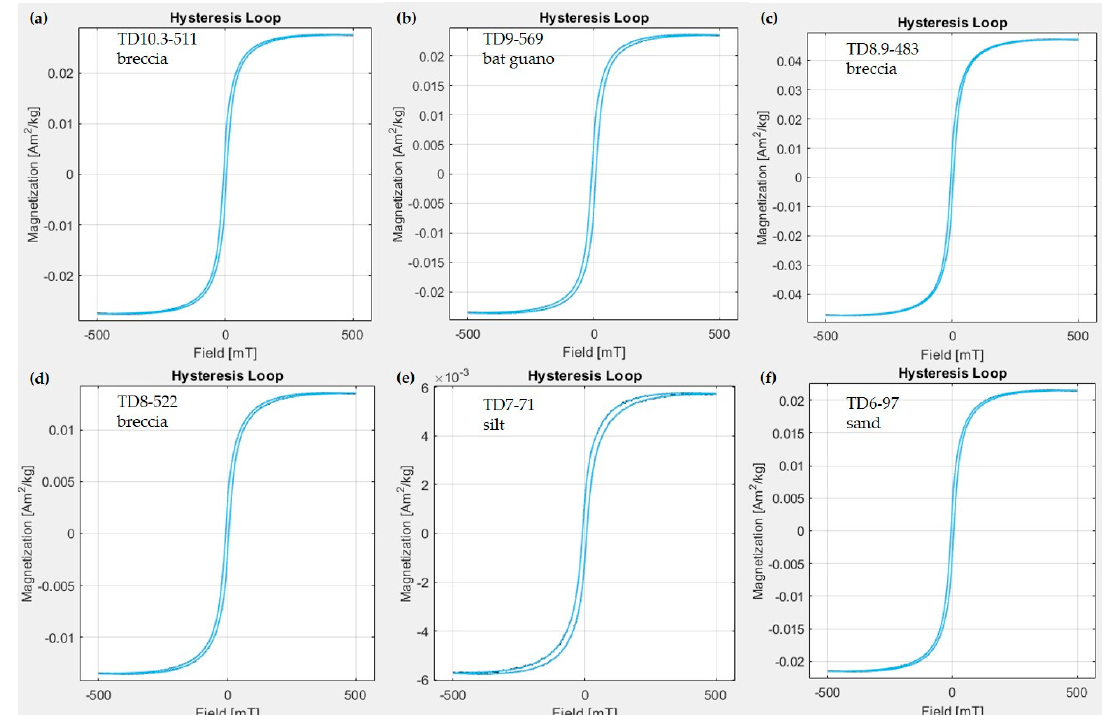
Figure 5. Magnetic hysteresis loops of representative specimens from different stratigraphic depths, measured with the Magnetometer MicroMag VSM up to a maximum applied field of 500 mT and mass normalized. Curves are corrected for paramagnetic contribution. ( a ) sample TD10.3–511. ( b ) sample TD9–569. ( c ) sample TD8.9–483. ( d ) sample TD8–522. ( e ) sample TD7–71. ( f ) sample TD6–97.